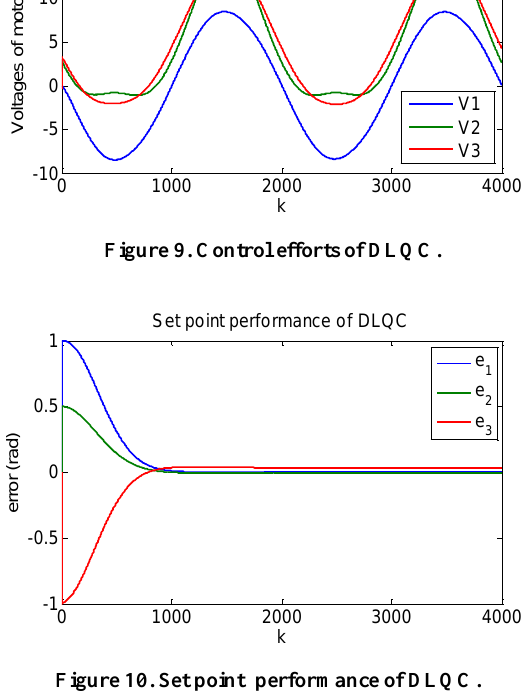
Figure 10. Set point performance of DLQC.